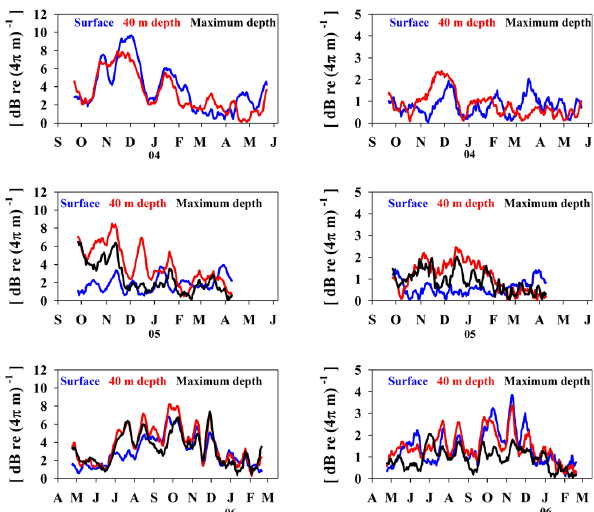
Fig. 12. (left) Time evolution of the amplitude of the 24h and (right) 12h harmonics at different depths. Year is indicated below January label.